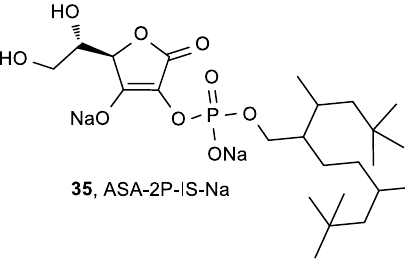
Figure 15. ASA-2P-IS-Na with an inhibitory effect on melanogenesis.